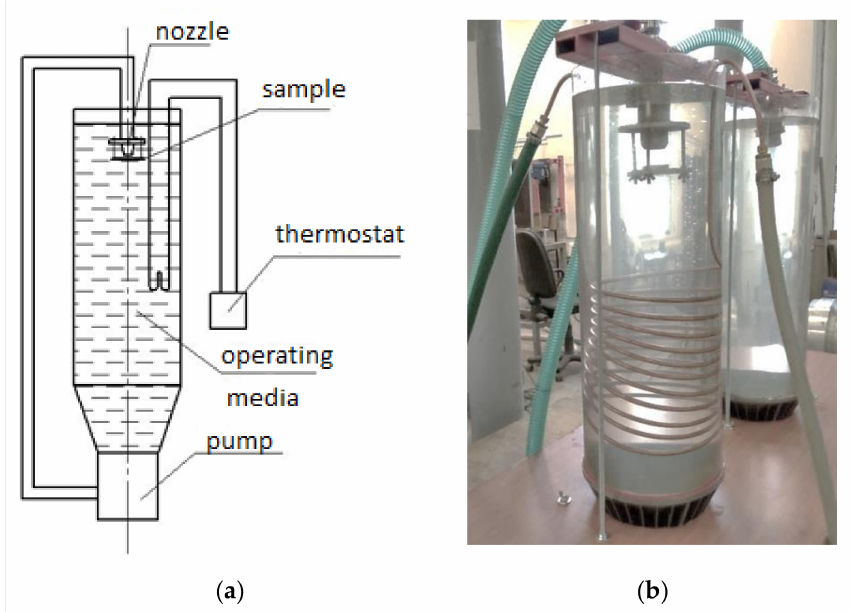
Figure 1. Stand for testing for hydroabrasive wear: ( a ) stand diagram; ( b ) general view of the hydroabrasive wear